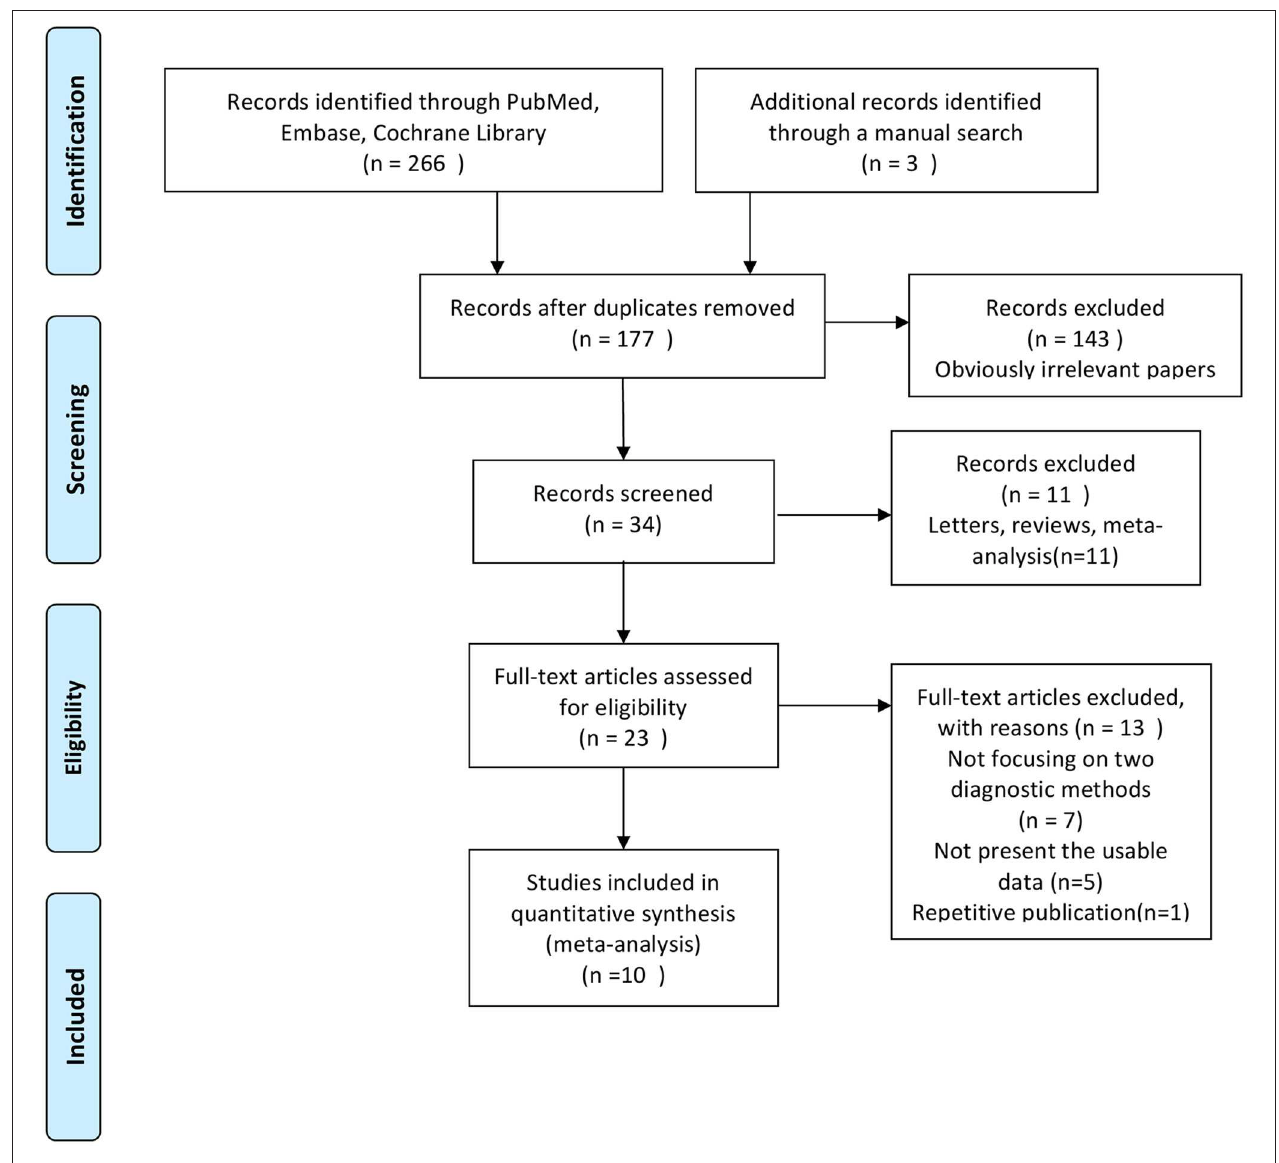
FIGURE 1 | Flow diagram for identification of